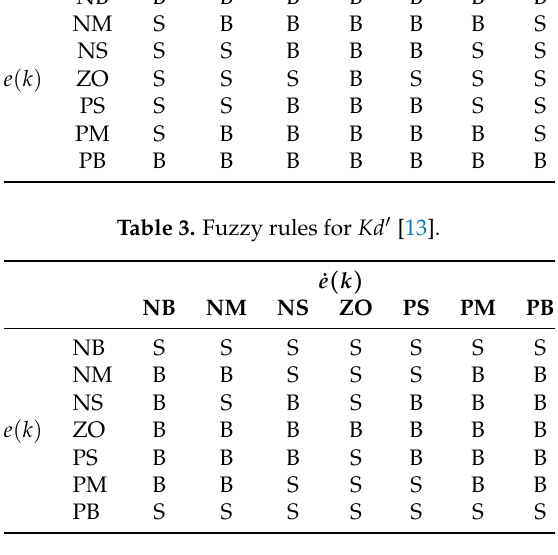
Table 4. Fuzzy rules for α